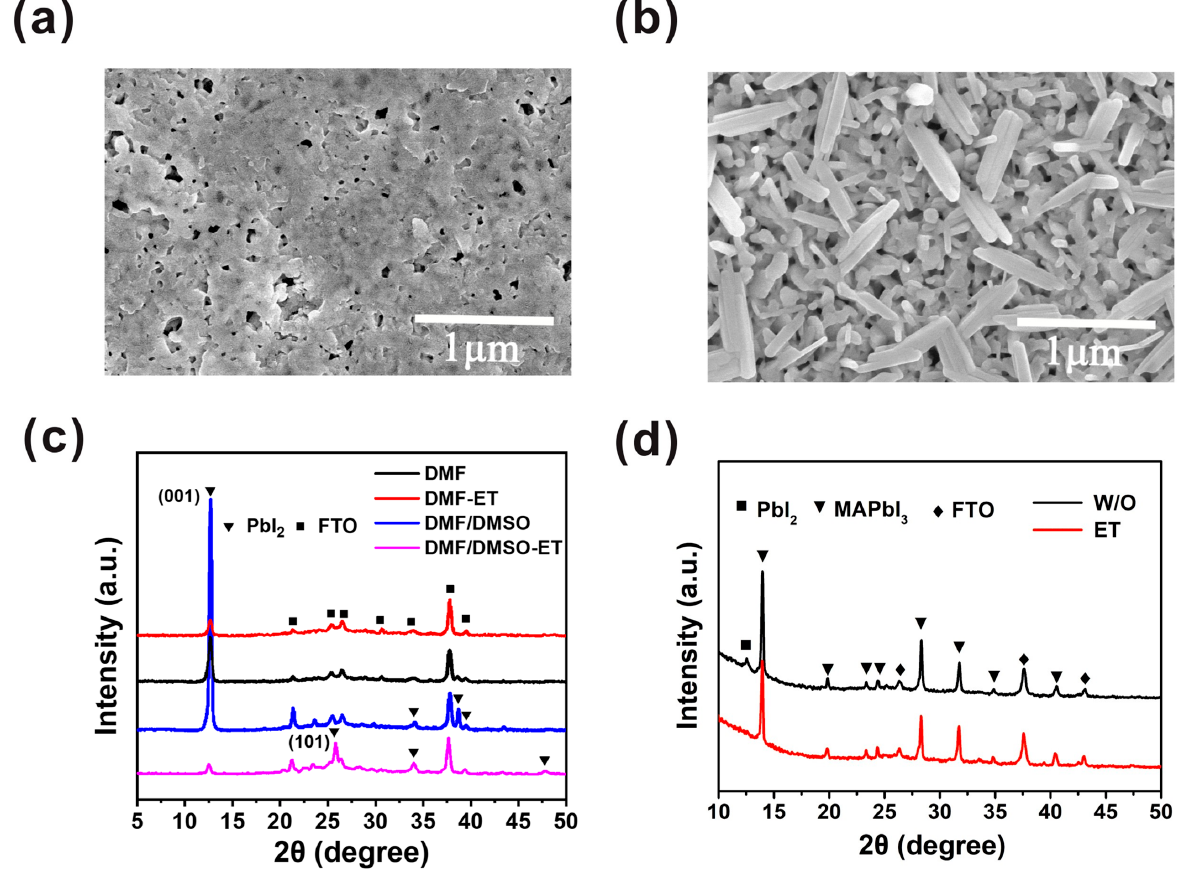
Figure 3. Characterization of PbI 2 and MAPbI 3 perovskite films without and with ethanol treatment. ( a ) SEM top view image of PbI 2 film without ethanol treatment. ( b ) SEM top view image of PbI 2 film with ethanol treatment. ( c ) XRD patterns of PbI 2 films without and with ethanol treatment. ( d ) XRD patterns of corresponding MAPbI 3 films without (black line) and with (red line) ethanol treatment.